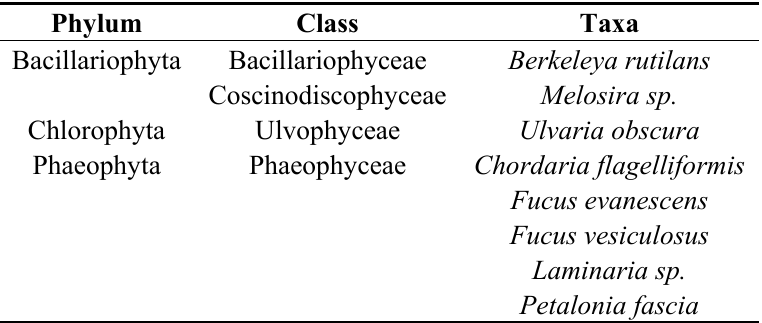
Table 1. List of the 24 taxa identified within the rock